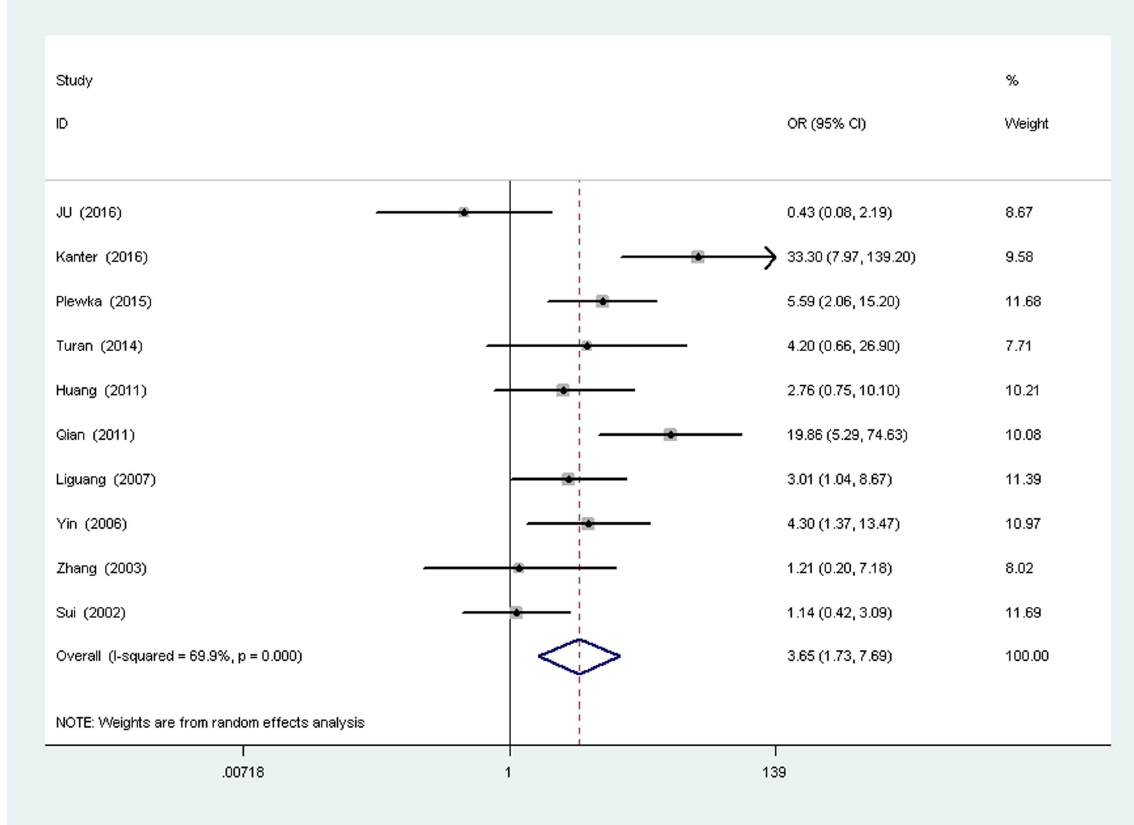
Fig 4. Forest plot depiction of survivin expression and odds ratio (OR) for ovarian carcinoma vs borderline ovarian